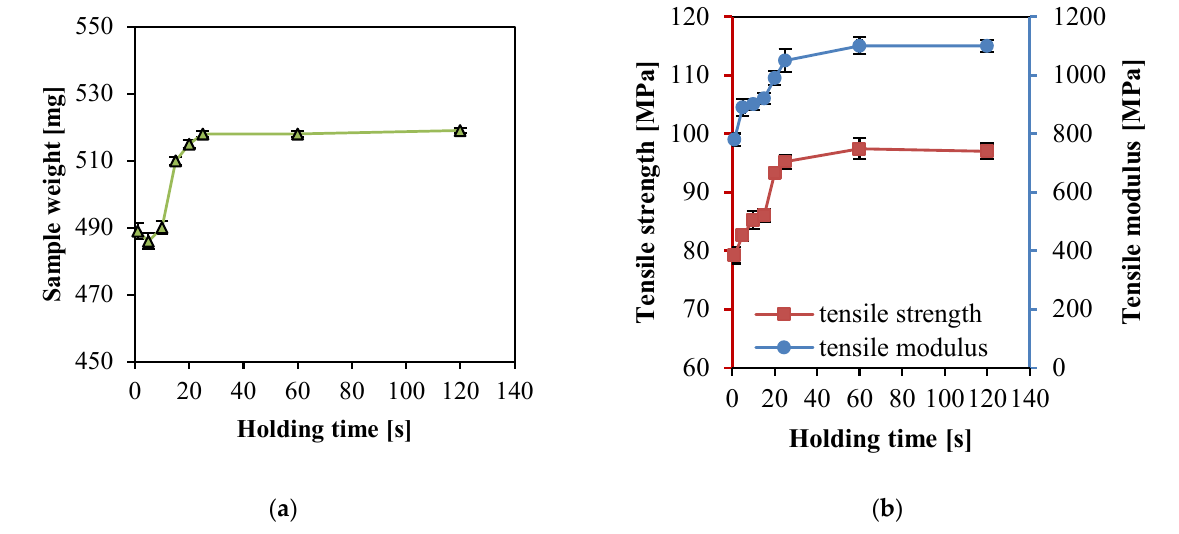
Figure 7. Properties of the PP SPC samples prepared with different holding times: ( a ) weight, and ( b ) tensile and tensile modulus.